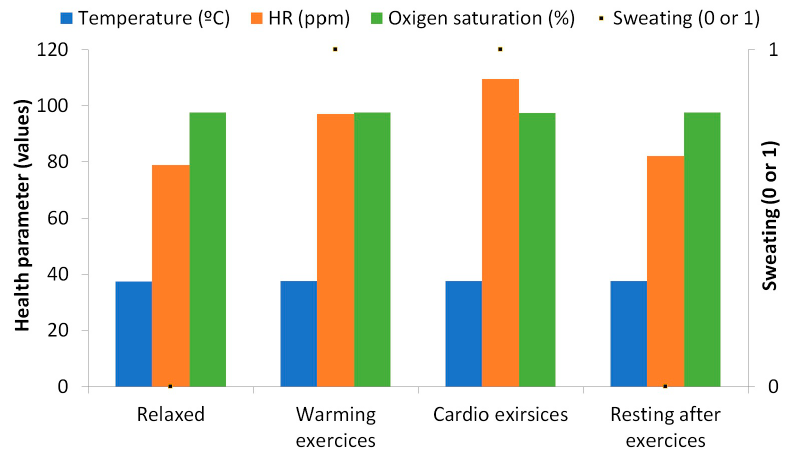
Figure 12. Wellness parameters measurements from preliminary tests of the prototype.